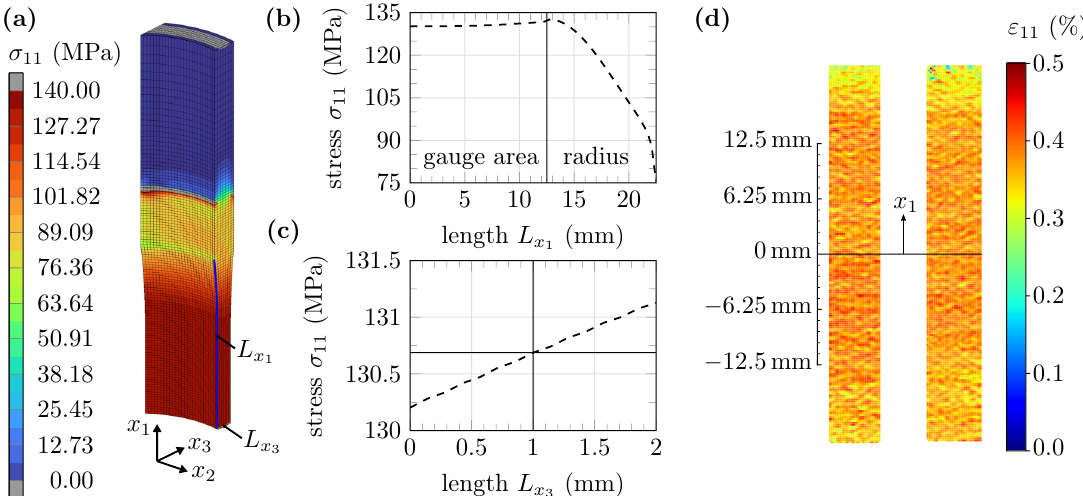
Figure 3. Verification of the hot-bent uniaxial specimen: ( a ) normal stress field σ 11 ( x 1 , x 2 , x 3 ) of a FEM analysis of a quarter model of the hot-bent specimen; ( b ) plot of the stress σ 11 over the path L x ( d ) strain field ε 11 ( x 1 , x 2 , x 3 ) , measured with DIC, of the hot-bent specimen with marked gauge area at an extensometer strain ε 11,ext = 0.45%.